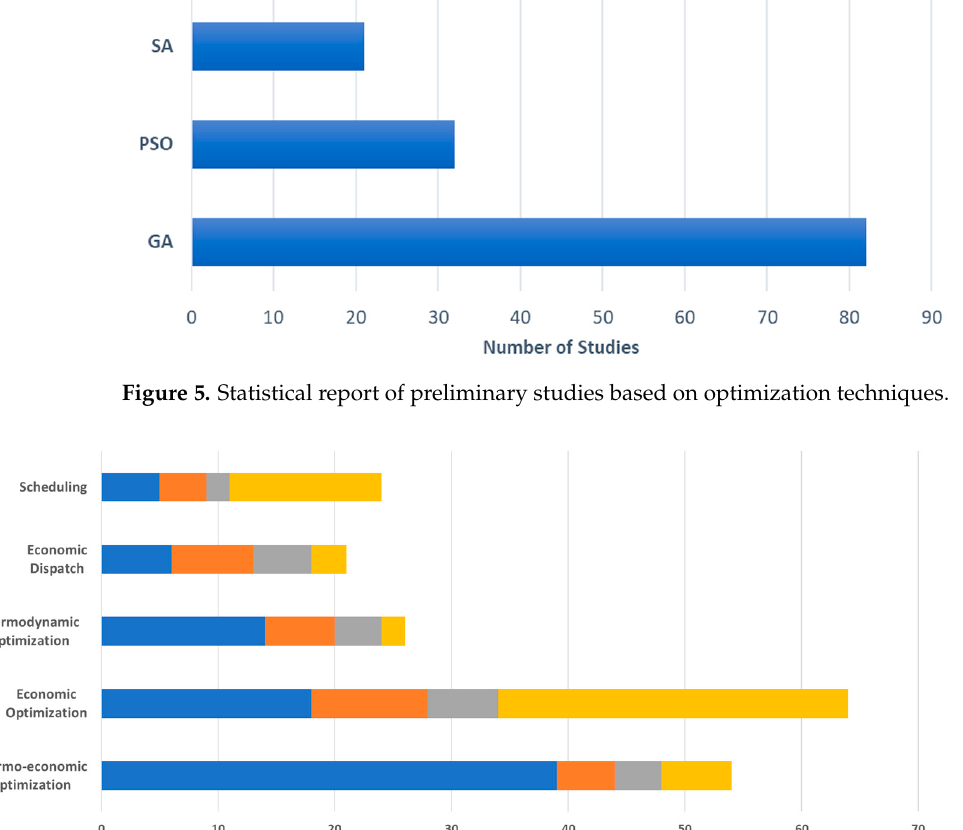
Figure 6. Statistical report of preliminary studies based on the optimization purpose and method.